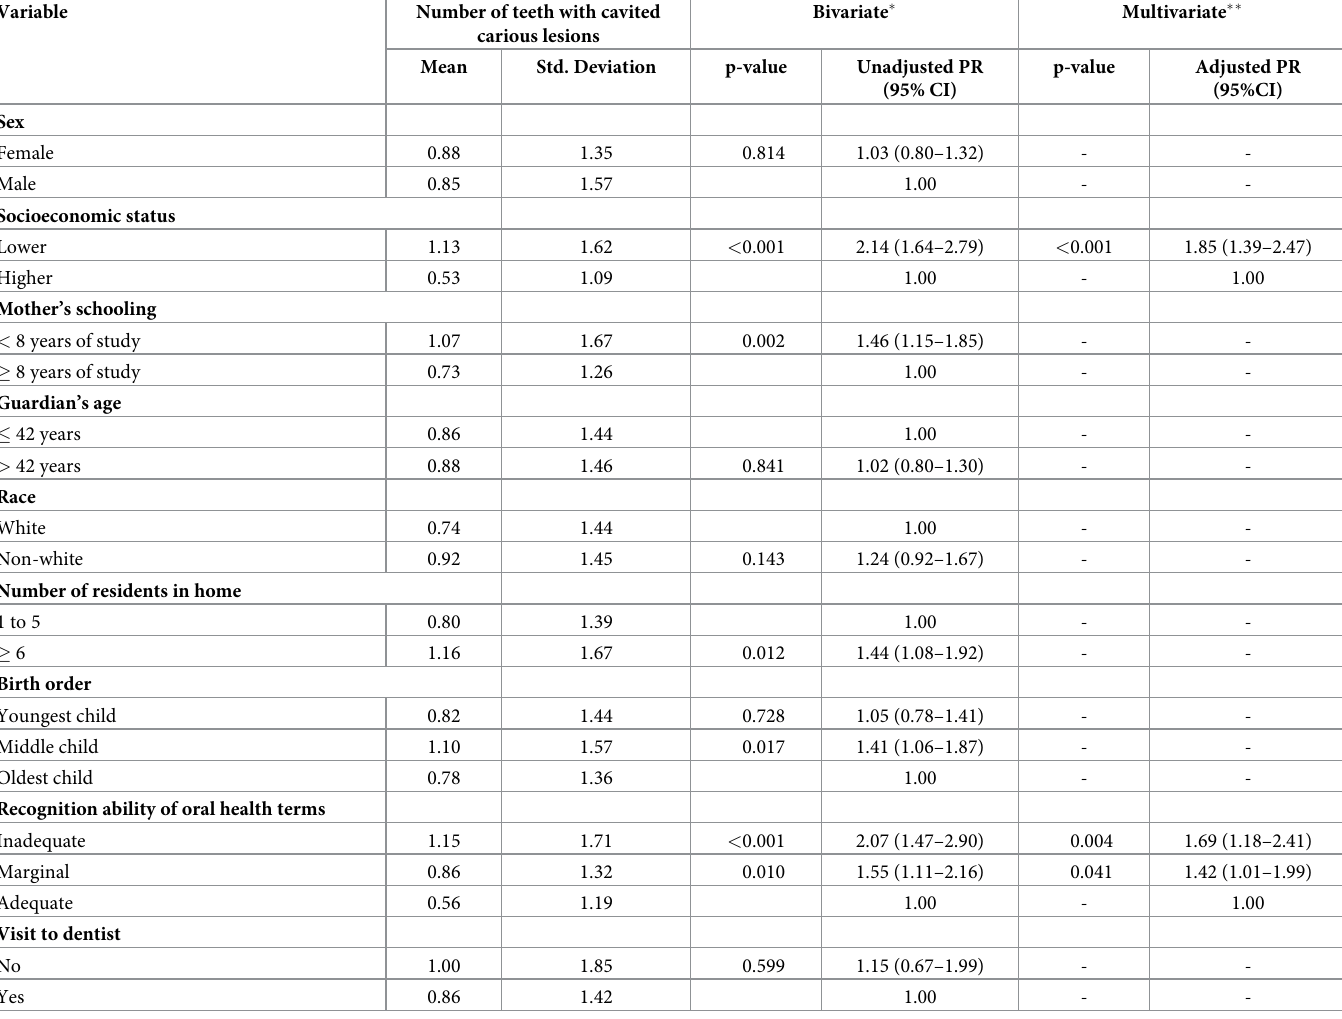
Table 2. Poisson regression analyses of variables associated with the number of teeth with cavitated carious lesions in adolescents.